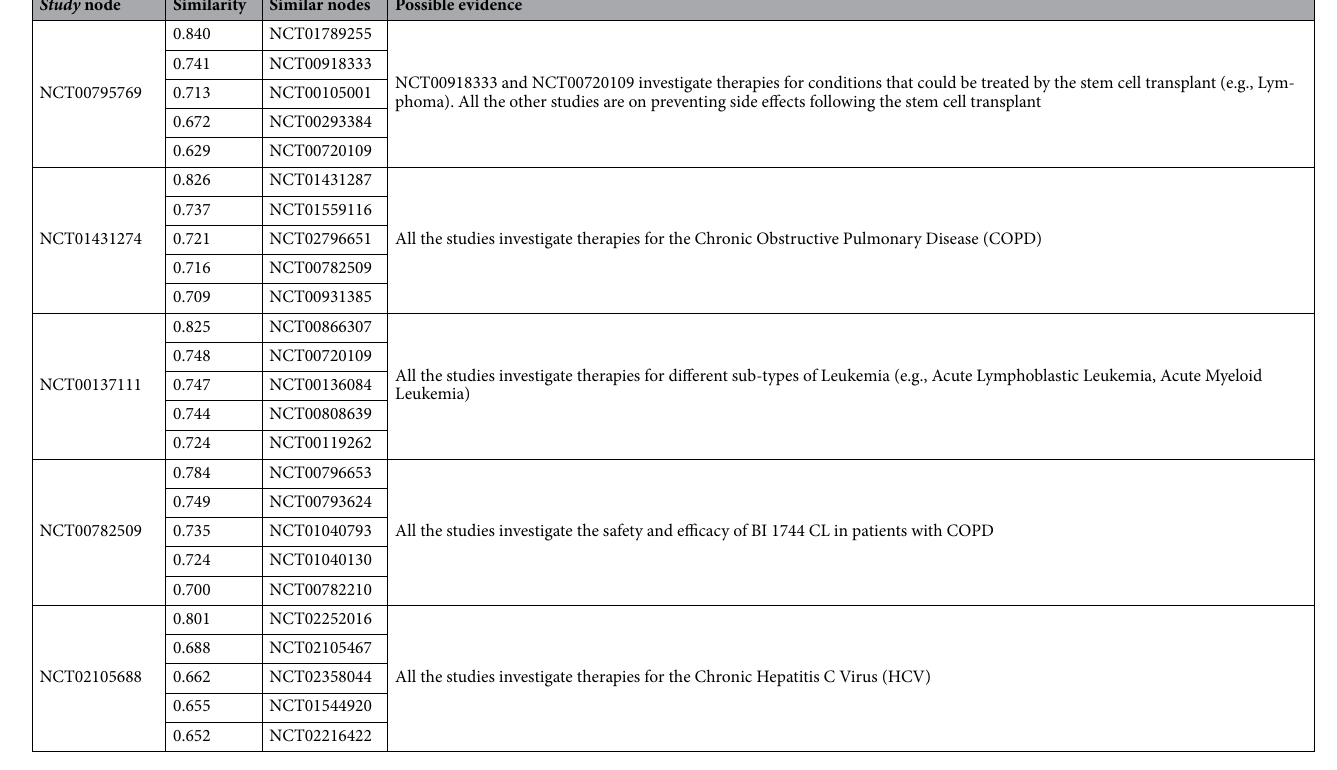
Table 4. Similar study nodes. The average cosine similarity among Study nodes is